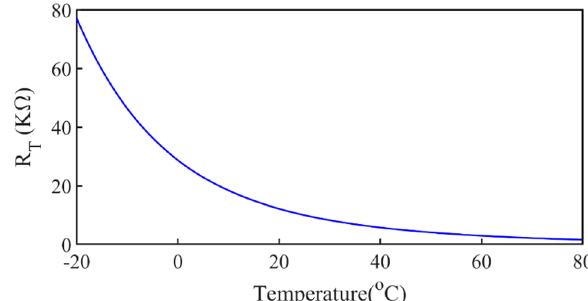
Figure 18. R T versus temperature.